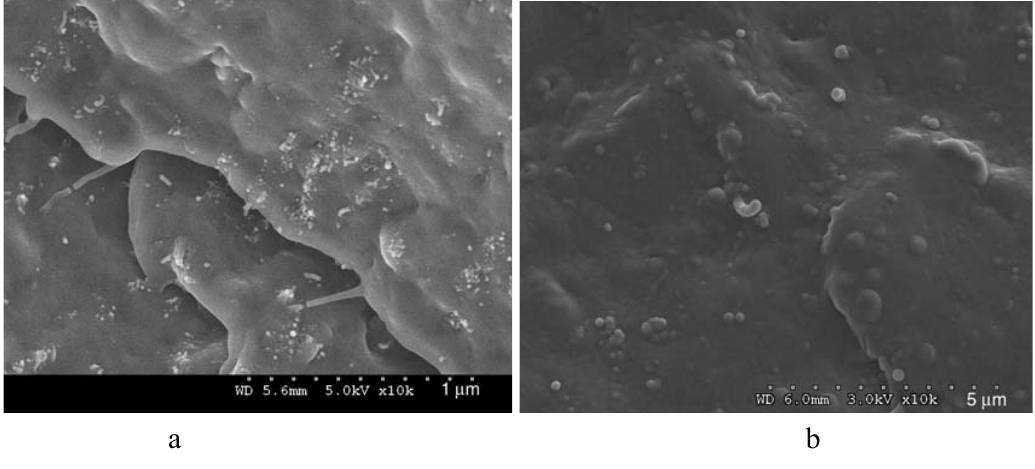
Figure 44. SEM images of a) CNTs-MA-PP composite and b) CNTs/PP composite. Reproduced with permission from ref.